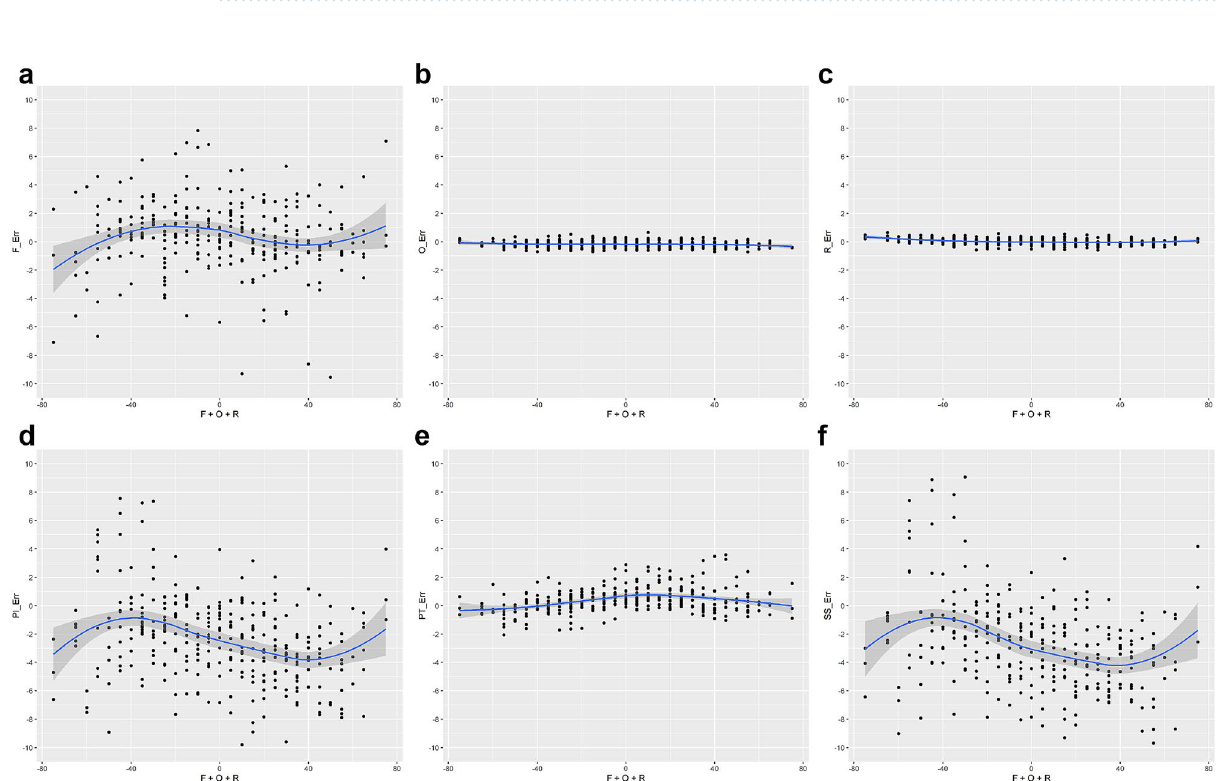
13.47° of global uncertainty. For individual raters, the global uncertainty of flexion ranged from 5.37° to 17.44° and that of SS ranged from 9.63° to 13.91°. Postural influence (Figs. 1 and 2). The LOESS plot for measurement errors of each parameters along the sum of pelvic orientation angles depicted that SS and flexion are more error prone than other parameters (Fig. 1). To focus on the measurement errors of these two parameters, we plotted multiple heat maps of meas- urement errors with positional variance. The heat maps showed that the three positional parameters—flexion, obliquity, and rotation—have a complex impact on measurement errors of SS (Fig. 2). The heat maps revealed two features of SS measurement errors. First, the sign of SS measurement errors tended to be similar to the sign of the product of flexion, obliquity, and rotation. Second, the absolute values of SS measurement errors correlated with the absolute values of the product of flexion, obliquity, and rotation.